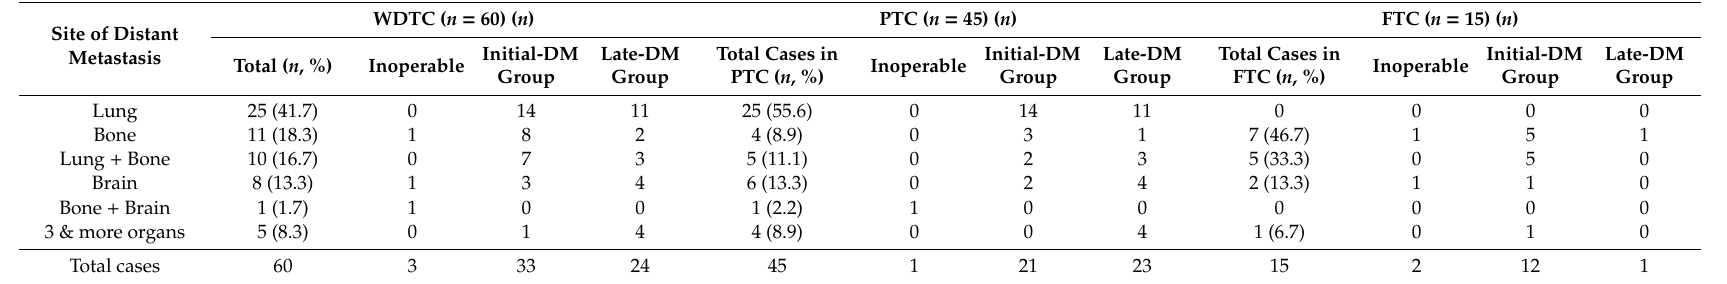
Table 5. Timing and site of distant metastasis in PTC and FTC